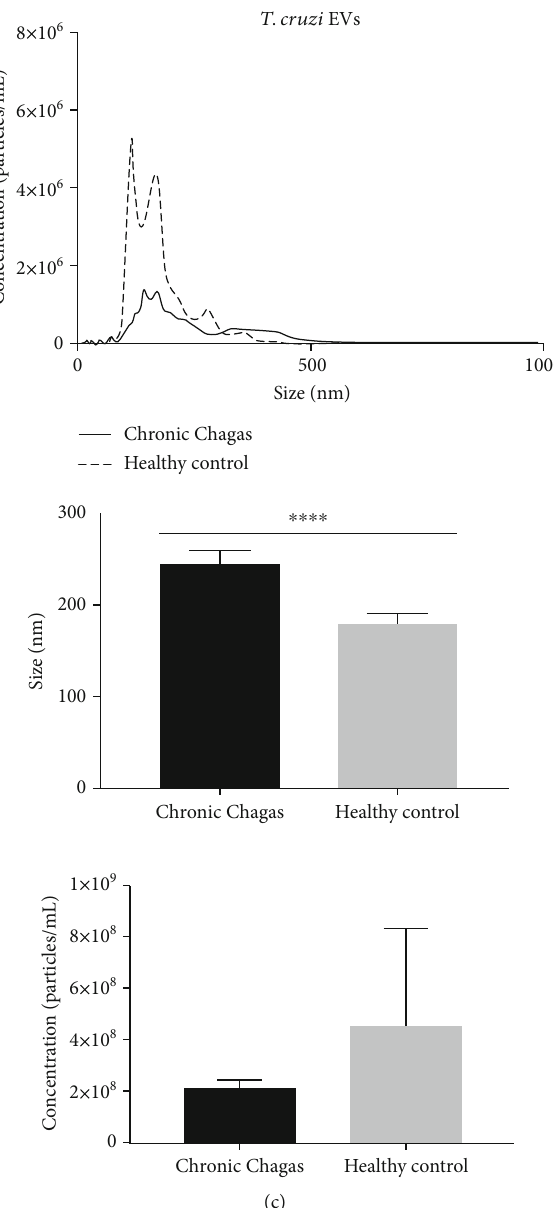
Figure 3: Comparison of EV pro fi les from CCD and CTRL PBMCs after a 24 h incubation. Concentration/size distribution (top), mean size ± 95 % CI (center) and meanconcentration ± 95 % CI (bottom) after (a) culture medium ( ∗ p = 0 : 0326 and ∗∗∗∗ p < 0 : 0001 ), (b) T. cruzi extract ( ∗∗∗ p = 0 : 0003 and ∗∗∗∗ p = 0 : 0002 ), or (c) T. cruzi EV stimuli ( ∗∗∗∗ p < 0 : 0001